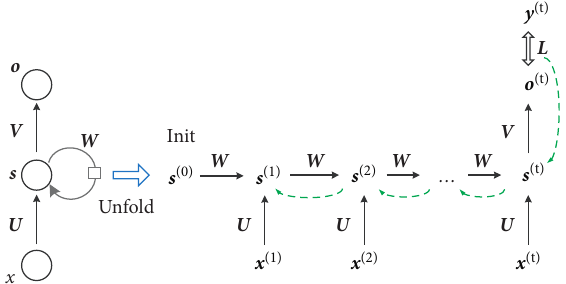
Figure 2: The many-to-one RNN model used in this study. The right is the unfolded form, where U , V , and W are the uniform weight matrices. The loss L between the only output o (t) and the goal y (t) is used in the backpropagation for updating model